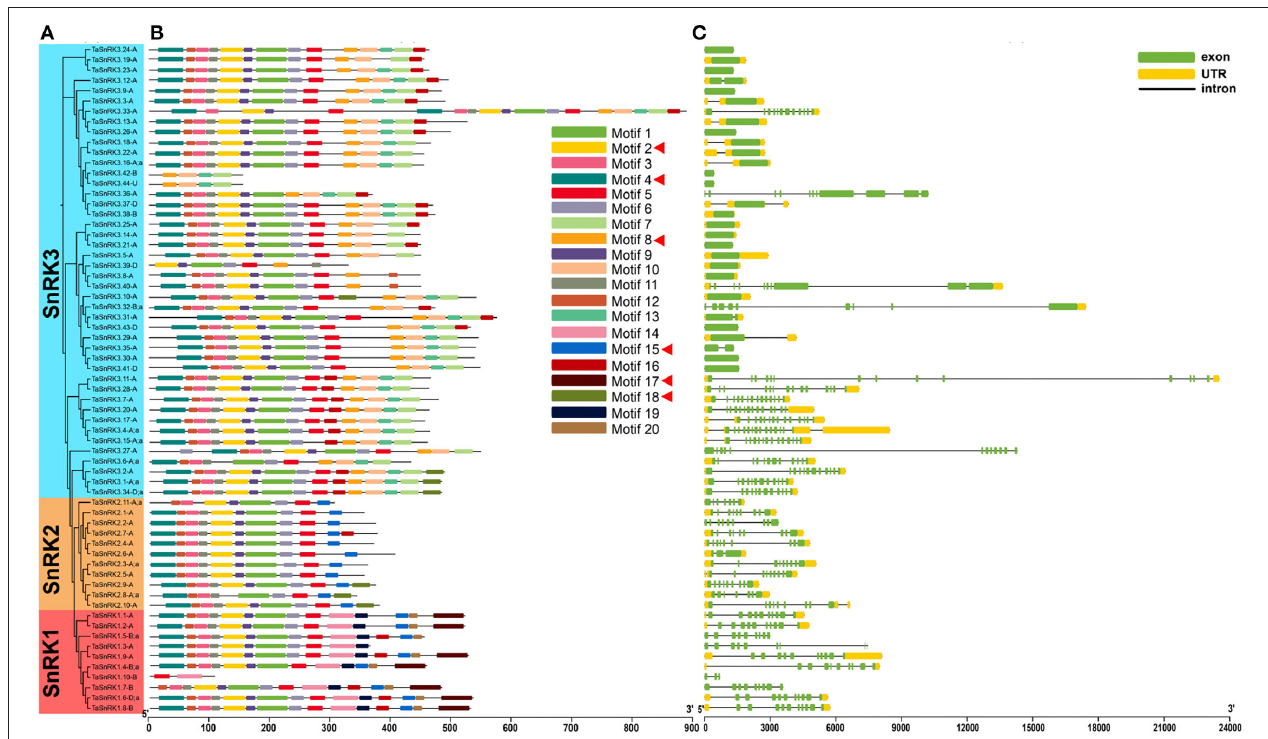
FIGURE 2 | Motif composition and exon-intron structure of 65 representative TaSnRKs. (A) Phylogenetic tree of TaSnRKs was created by MEGA X with the neighbor-joining (NJ) method. (B) Motif composition of TaSnRKs. Different motifs are indicated by a specific color. The red triangle indicates motifs related to the functional domains. (C) Gene structure of TaSnRKs. Gene structure and motif analyses of 186 TaSnRKs can be found in Supplementary Material 4